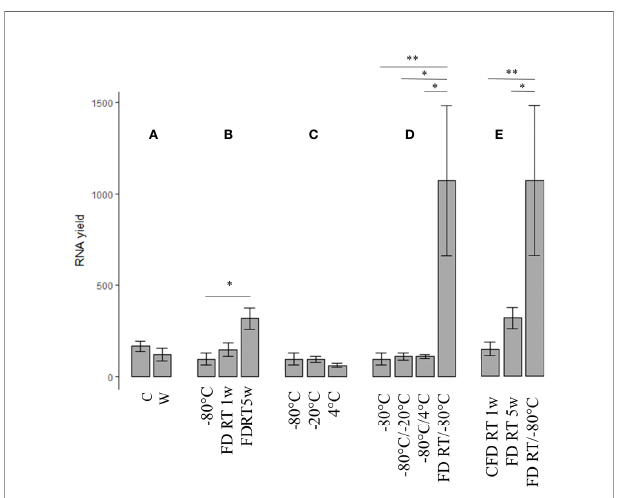
FIGURE 3 | The impact of tissue form (crushed vs whole) (n = 15), FD treatment, temperature, and temperature shifts assessed on extraction yield (n = 3). A = C vs. W, B = FD conditions vs. gold standard ( − 80°C), C = suboptimal temperature conditions ( − 20°C, 4°C) vs. gold standard, C = Temperature shifts vs. gold standard, D = Changing preservation conditions vs. gold standard and E = Comparison of all FD conditions.. Nomenclature is as described in Table 1 . C, crushed bean; W, whole bean; FD, freeze-dried; RT, room temperature; w, week (s). (Error bars indicate µ ± SEM) *p < 0.05, **p < 0.01. Details of signi fi cance levels between conditions can be found in Supplementary Tables S5 and S6A .